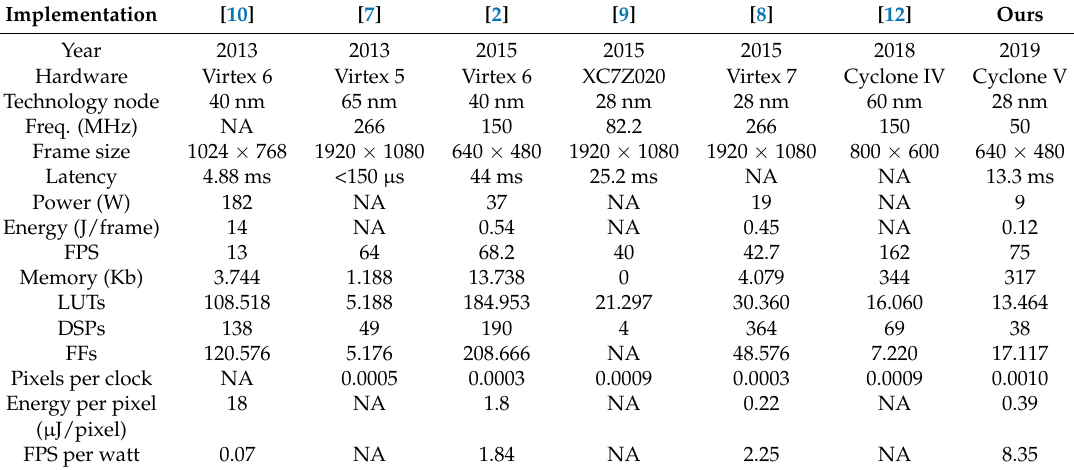
Table 1. Comparison with the